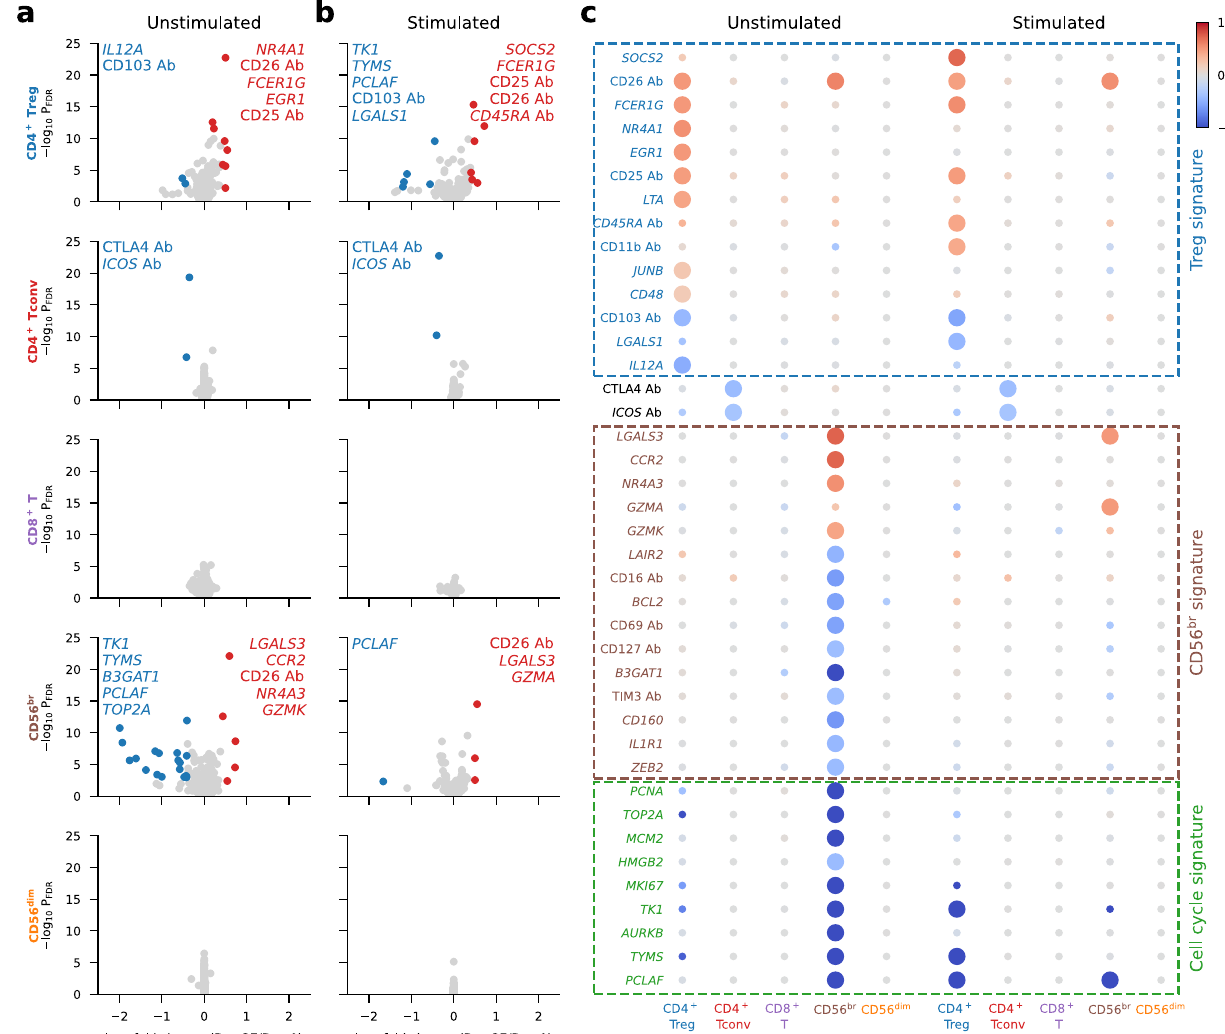
expressedinatleastonecellpopulationcomparingDay27withDay0.Dotcolours representlog 2 foldchangebetweenDay0andDay27.Largerdotsrepresentgenes that are signi fi cantly differentially expressed in the respective cell